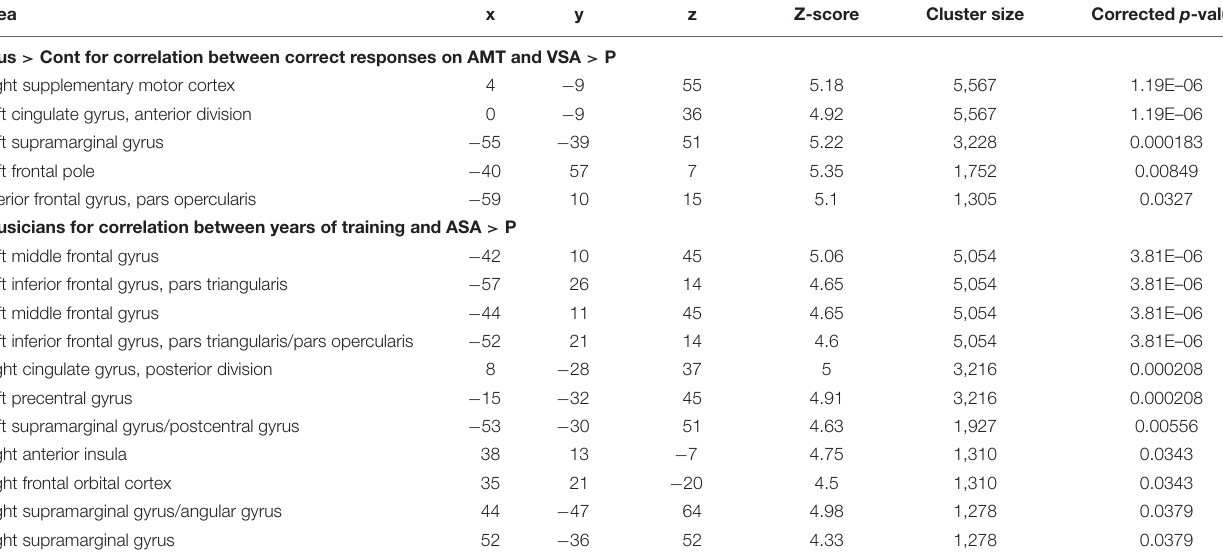
Mus, musically trained children; Cont, control children; ASA, auditory selective attention condition; VSA, visual selective attention condition; DA, divided attention condition; P, passive condition; AMT, auditory memory